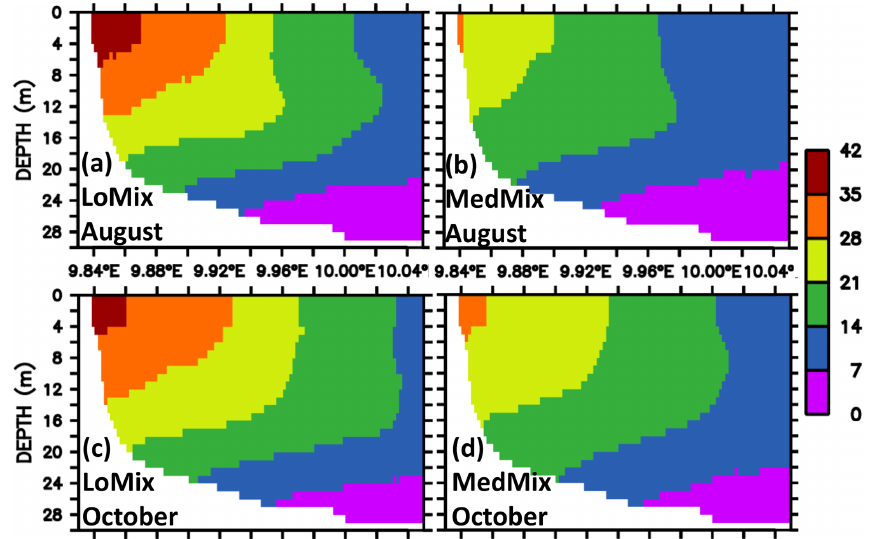
Figure 8. Simulated climatological estimate of the residence times of water parcels in EB. The units are days elapsed since the water flushed into the bight. Sections along EB are shown. Panels (a) and (b) refer to August calculated by the simulations LoMix and MedMix , respectively. Panels (c) and (d) refer to October calculated by the simulations LoMix and MedMix , respectively. Note that the model domain extends beyond the eastern boundary shown here (see also Fig.